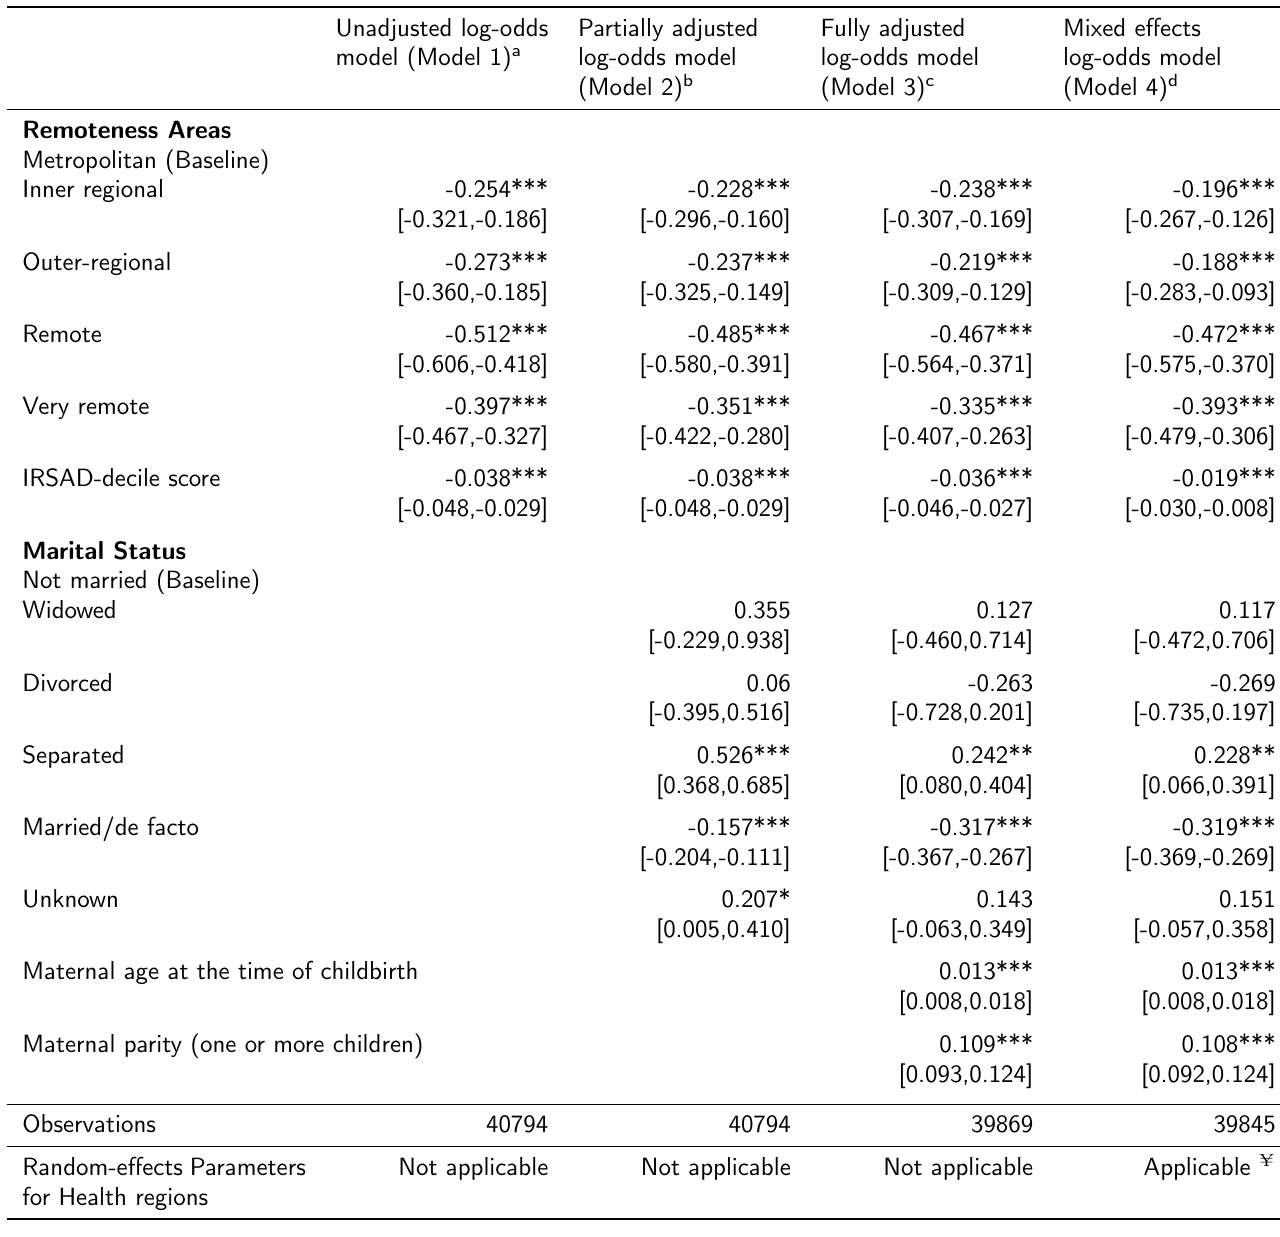
Table 2: Log-odds regression models predicting probability of maternal mental health by IRSAD and geographic